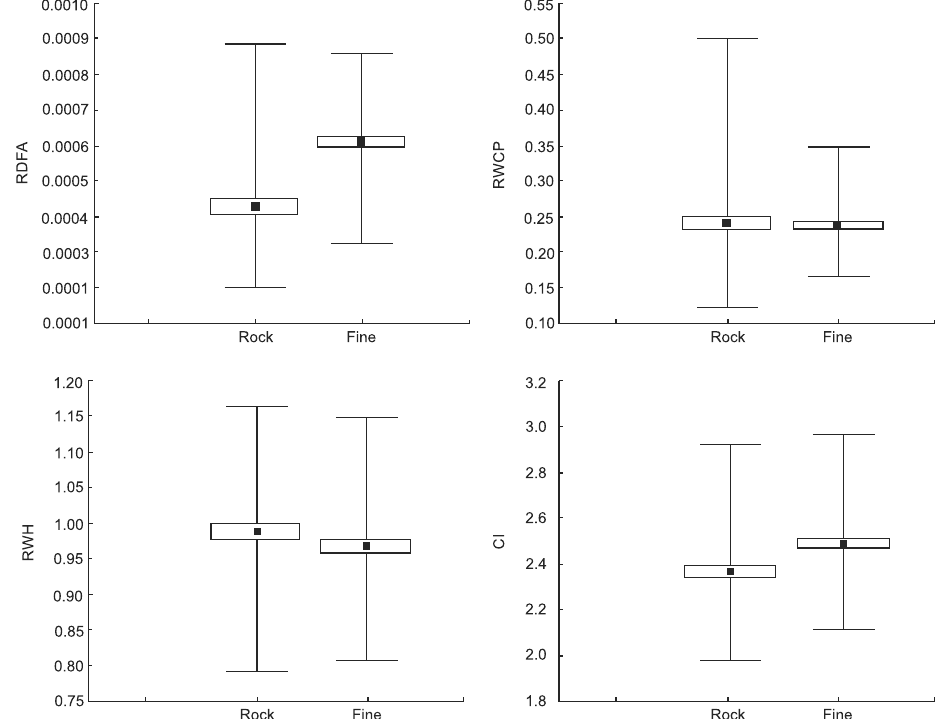
Figure 4. The means, standard deviations, and minimum and maximum values for the ecomorphological attributes of Astyanax interme- dius present in streams with different substrates collected from Rio São Francisco streams in September 2010. CI (compression index), RWCP (relative width of caudal peduncle), RWH (relative width of head), and RDFA (relative dorsal fin